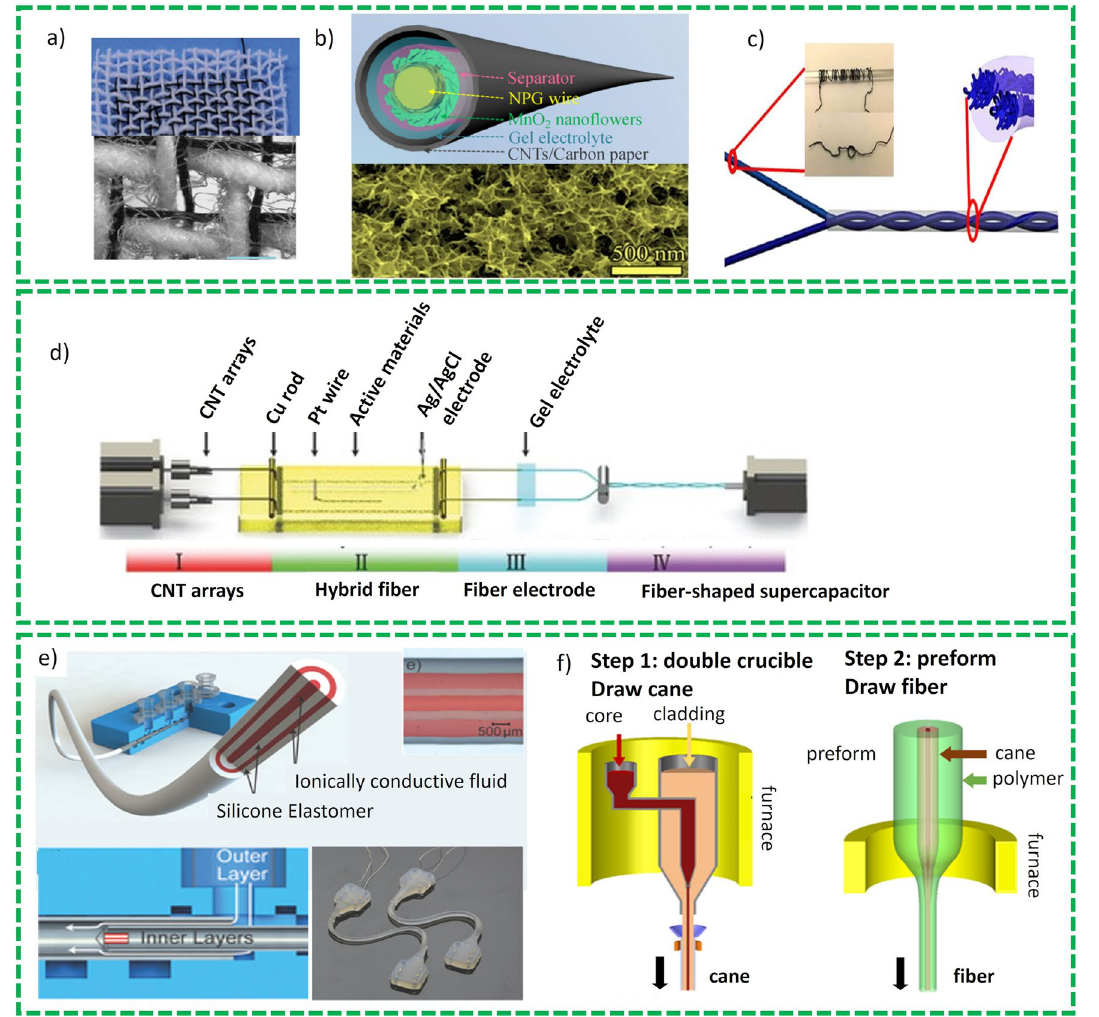
Fig. 19 a – c FSEDs with different configurations, twisted, coaxial and interlaced or woven. a Reprinted with permission from Ref. [207], b Reprinted with permission from Ref. [208], c Reprinted with permission from Ref. [209]. d – f Large-scale production techniques for deposition, spinning, and thermal drawing techniques, e Reprinted with permission from Ref. [210], f Reprinted with permission from Ref.